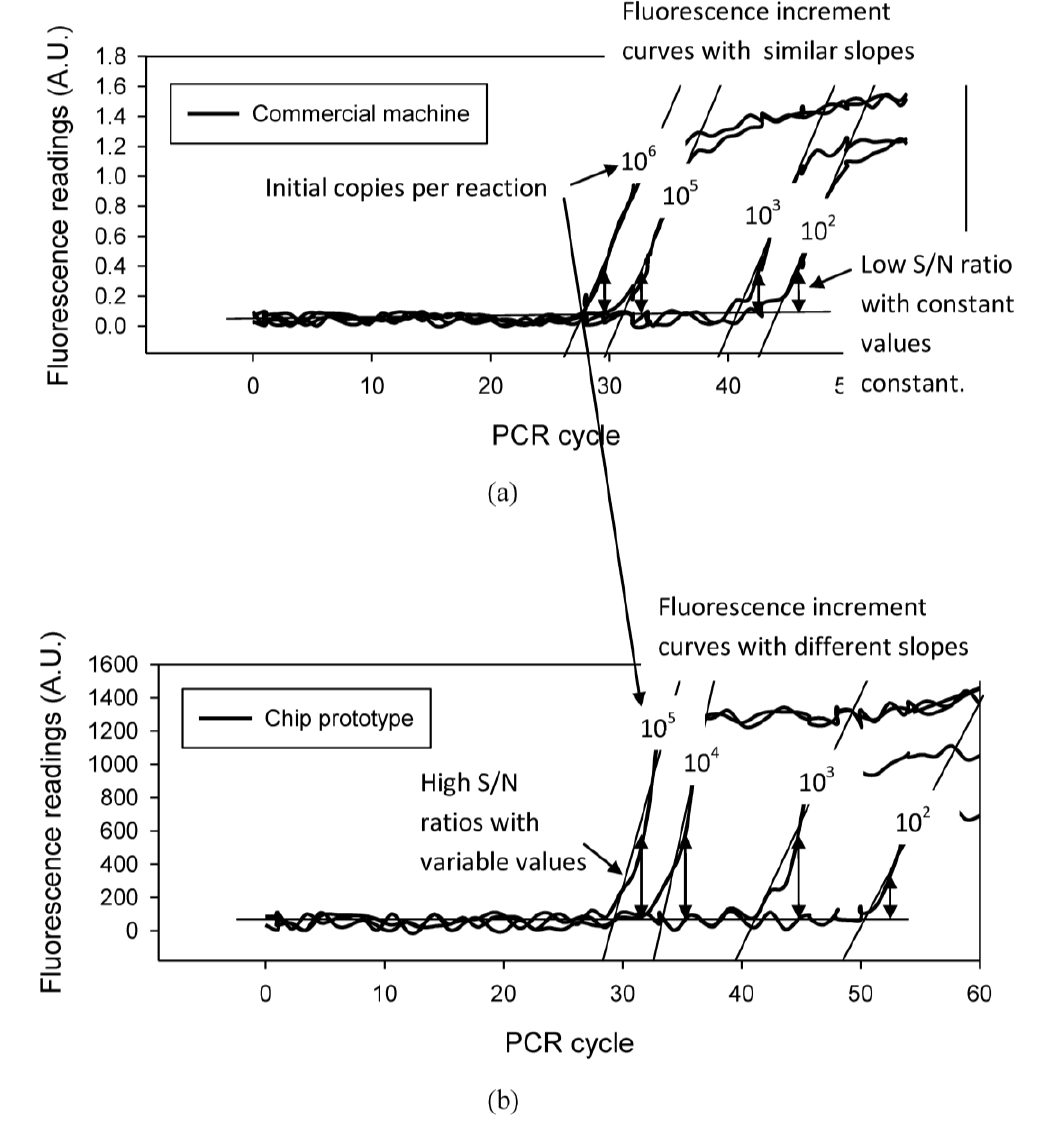
Figure 10. Quantification results of a commercial machine (a) and the chip (b) for a serial sample of different initial copy numbers. The figures illustrate that the chip-orientated fluorimeter design provides high sensitive detection but the fluorescence increment curves with different slopes yield variable S/N ratios. This indicates the inconsistency and low reproducibility of DNA quantification by a chip with only one nano-liter sample